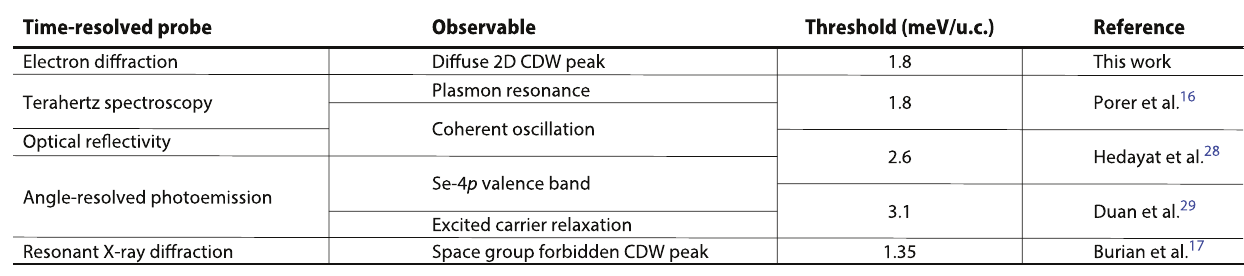
Table 1 Energy threshold for melting the exciton order based on different observables in various pump-probe techniques, expressed in terms of absorbed energy per normal state unit cell